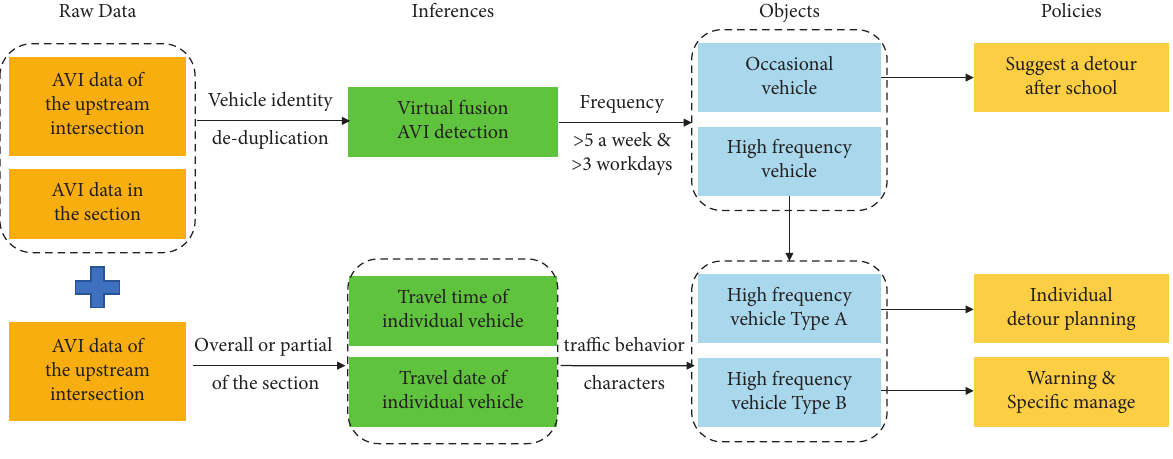
Figure 7: Framework of key vehicles clustering.